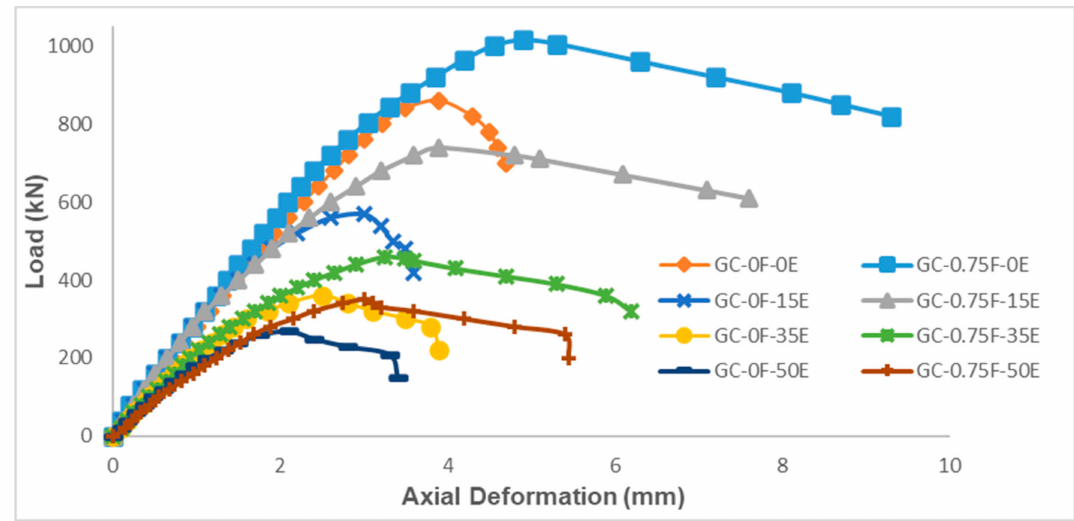
Figure 10. The axial load–axial displacement behavior of GC columns.